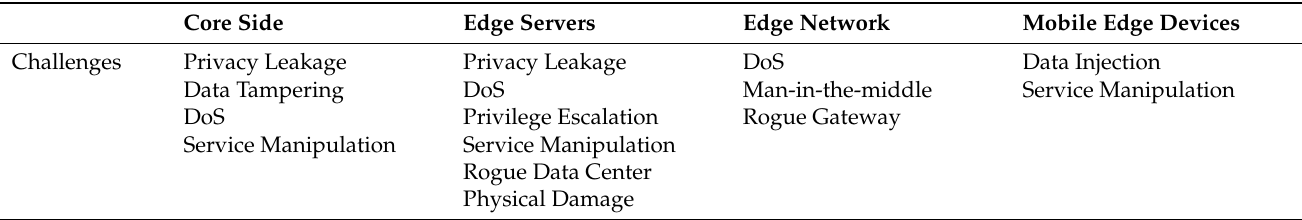
Table 3. Security Attack in Edge Computing